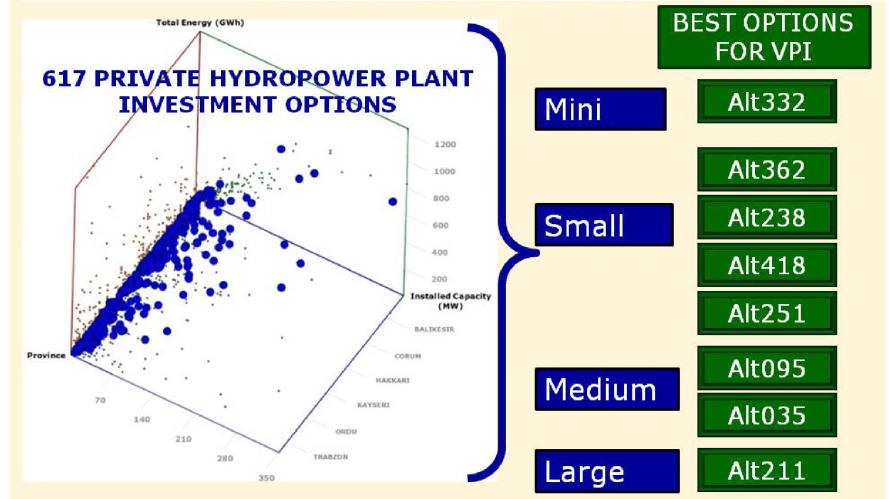
Figure 5. The best options in the PHPI data set for the